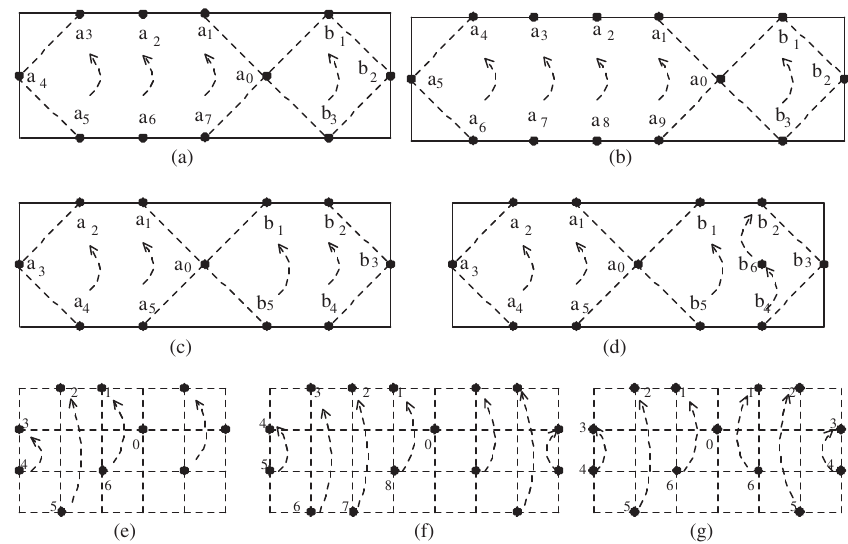
Figure 3. ( a ) C 2,8